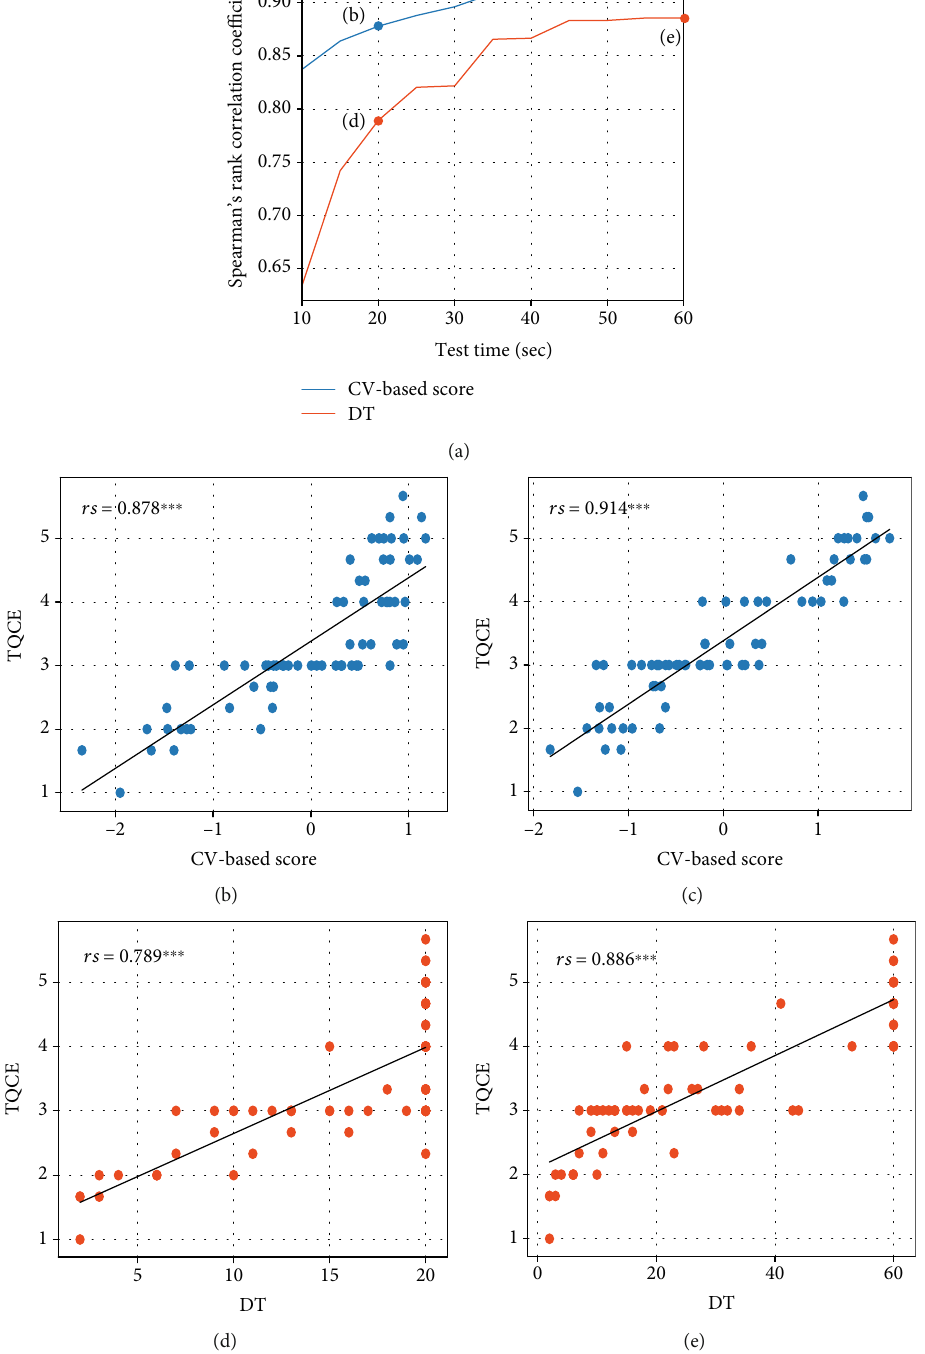
Figure 3: Comparison of the CV- and DT-based models. (a) Correlation coe ffi cient between TQCE and CV- (blue) or DT-based (orange) models for every 10s of test time. (b) Scatter plot of CV-based scores and TQCE at the test time of 20 s. (c) Scatter plot of CV-based scores and TQCE at the test time of 60 s. (d) Scatter plot of DT-based scores and TQCE at the test time of 20 s. (e) Scatter plot of DT- based scores and TQCE at the test time of 60s. ∗∗∗ p < 0 : 001